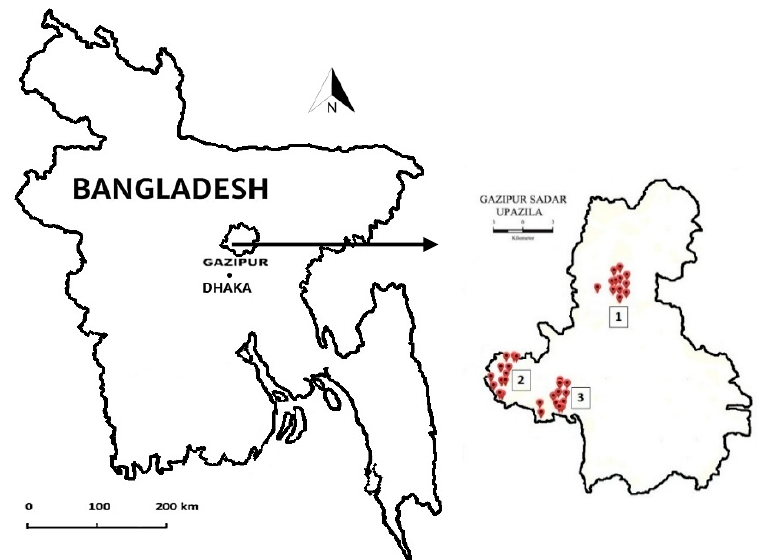
Figure 1. Sampling locations of irrigation water, soil, and vegetables in Gazipur District, Bangladesh. 1. Banglabazar; 2. Chandra; and 3. Kashimpur.